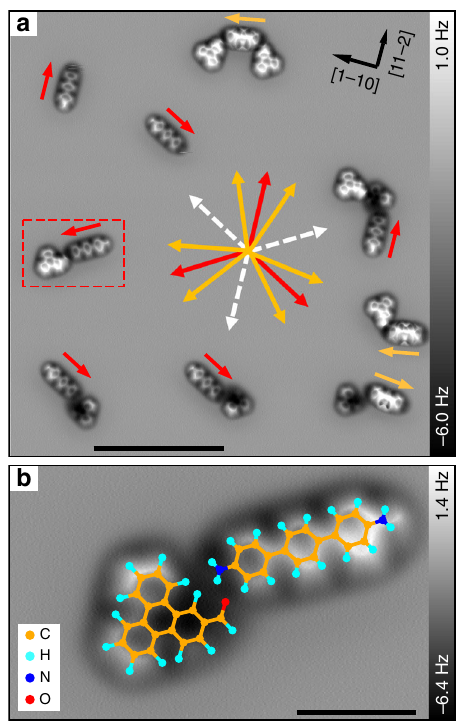
Fig. 5 Self-assembly of DATP and TPCA molecules. a AFM overview image. Fuzzy sides of DATP type I molecules are indicated by red arrows. DATP type II structures are indicated by orange arrows. In total six orientations of DATP type II molecules exist, which are rotated by − 21° and 21° with regard to the [11 − 2], [1 − 21], and [ − 211] directions (see also Supplementary Fig. 2). b AFM zoom-in image of a self-assembled DATP/ TPCA cluster. Zoom area is indicated in a by red dashed box. The TPCA is non-covalently bonded to the fuzzy side of the DATP molecule (see Supplementary Fig. 11). Molecular models are added to the respective molecules. The yellow, light blue, blue and red dots represent C, H, N and O, respectively. Scale bars: a 5 nm, b 1